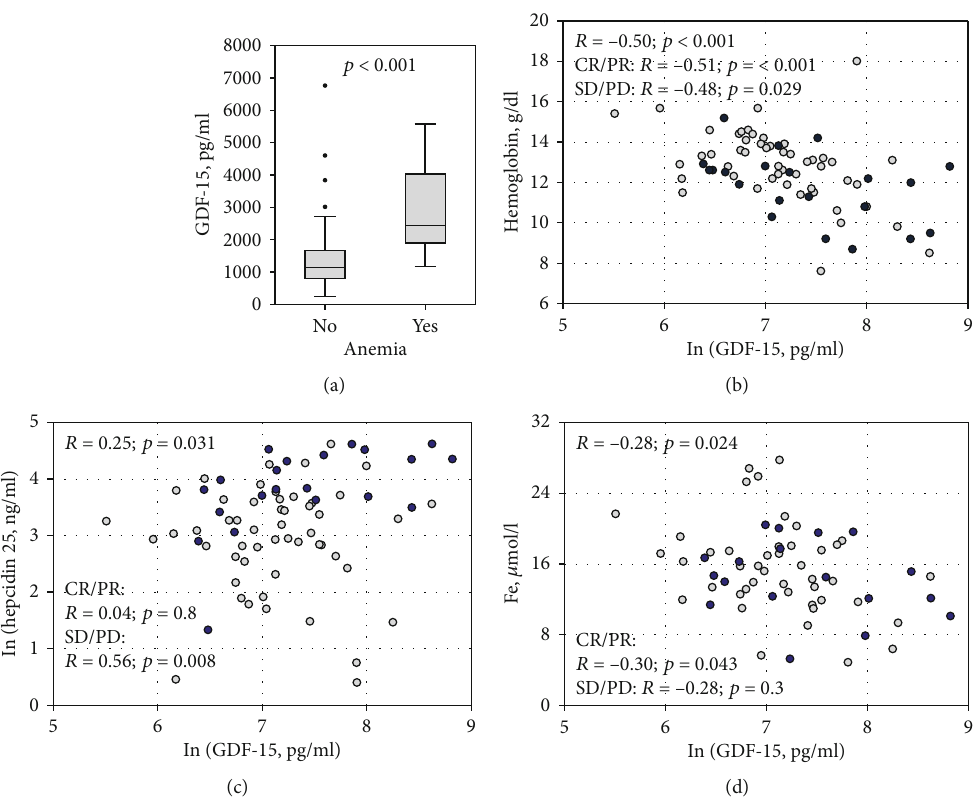
Figure 3: Serum GDF-15 concentrations among patients with ( n = 14 ) and without ( n = 59 ) anemia (a). Data are shown as median (horizontal line), interquartile range (box), nonoutlier range (whiskers), and outliers (points). Correlations between serum GDF-15 and blood hemoglobin (b), serum hepcidin 25 (c), and iron (d) in the studied patients. Light circles represent patients with complete or partial remission (CR/PR) and dark circles represent patients without remission (stable disease or progressive disease, SD/PD). The right-skewed variables were transformed using natural logarithm (ln) to enhance readability. The Spearman rank-order correlation coe ffi cients ( R ) in the whole studied group and the subgroups are shown with associated p